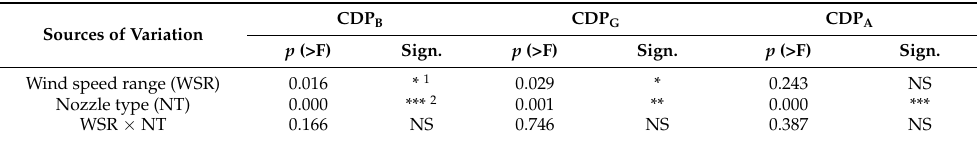
Table 4. Significance obtained from two-way ANOVAs for CDP B , CDP G , and CDP A , as affected by wind speed, nozzle type based on test bench, ground petri dish, and airborne drift collection frame. Sources of